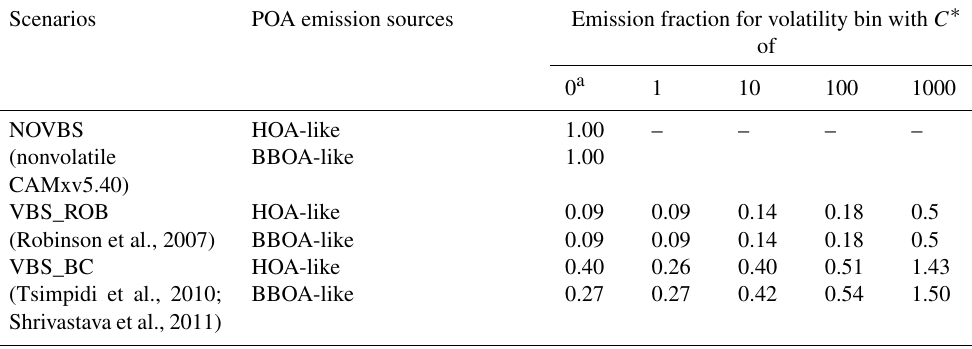
Table 1. Volatility distributions used for different scenarios. Scenarios POA emission sources Emission fraction for volatility bin with C